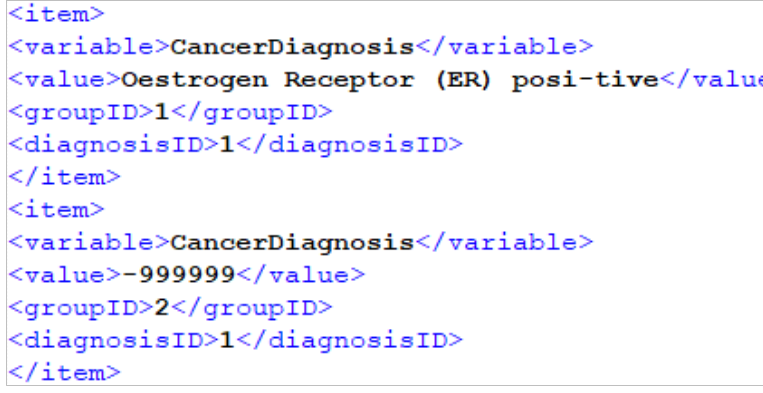
Figure 5. Output of CareAcross data from the Gateway